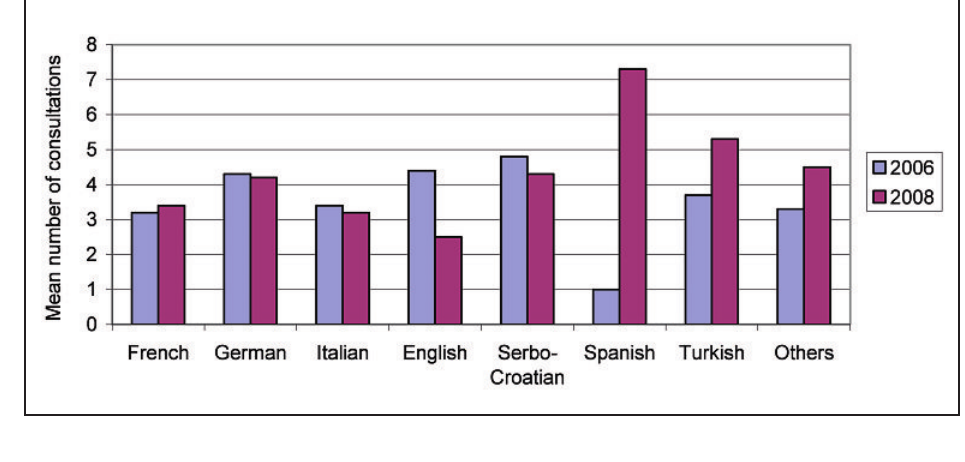
Figure 2 Box and whiskers diagram (mininum, maximum, median, 25 th and 75 th percentiles) displaying the distribution of the number of consulta- tions per patient per mother tongue in